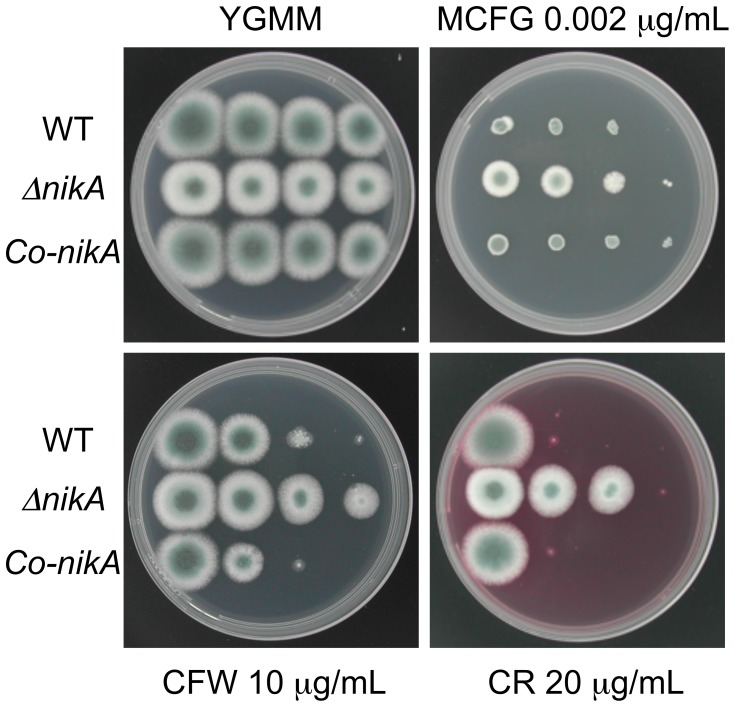
Growth of ΔnikA on plates containing cell wall-perturbing reagents.Series of diluted conidia suspensions (left to right: 104, 103, 102, and 10 conidia) of WT, ΔnikA, and Co-nikA were spotted onto YGMM plates with or without micafungin (MCFG), calcofluor white (CFW), or congo red (CR) at the indicated concentration. These plates were incubated at 37°C for 44 h and photographed.